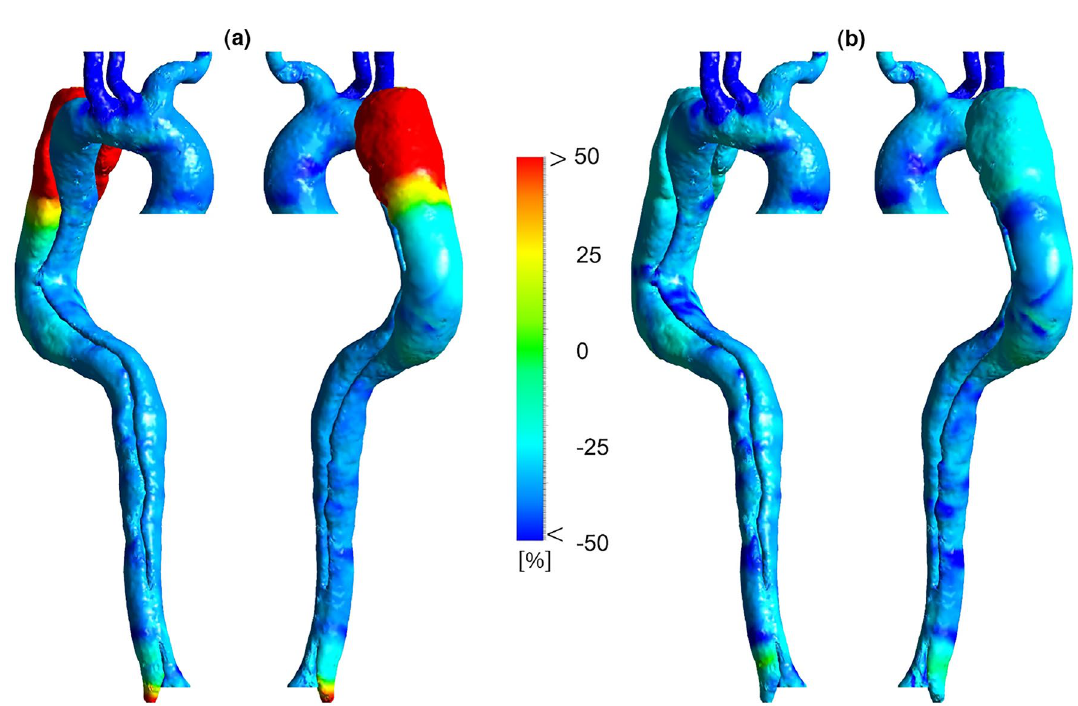
Figure 7. Percentage difference in time-averaged wall shear stress (TAWSS) according to different heart rates. ( a ) Percentage difference in TAWSS between 86 and 70 BPM. ( b ) Percentage difference in TAWSS between 55 and 70